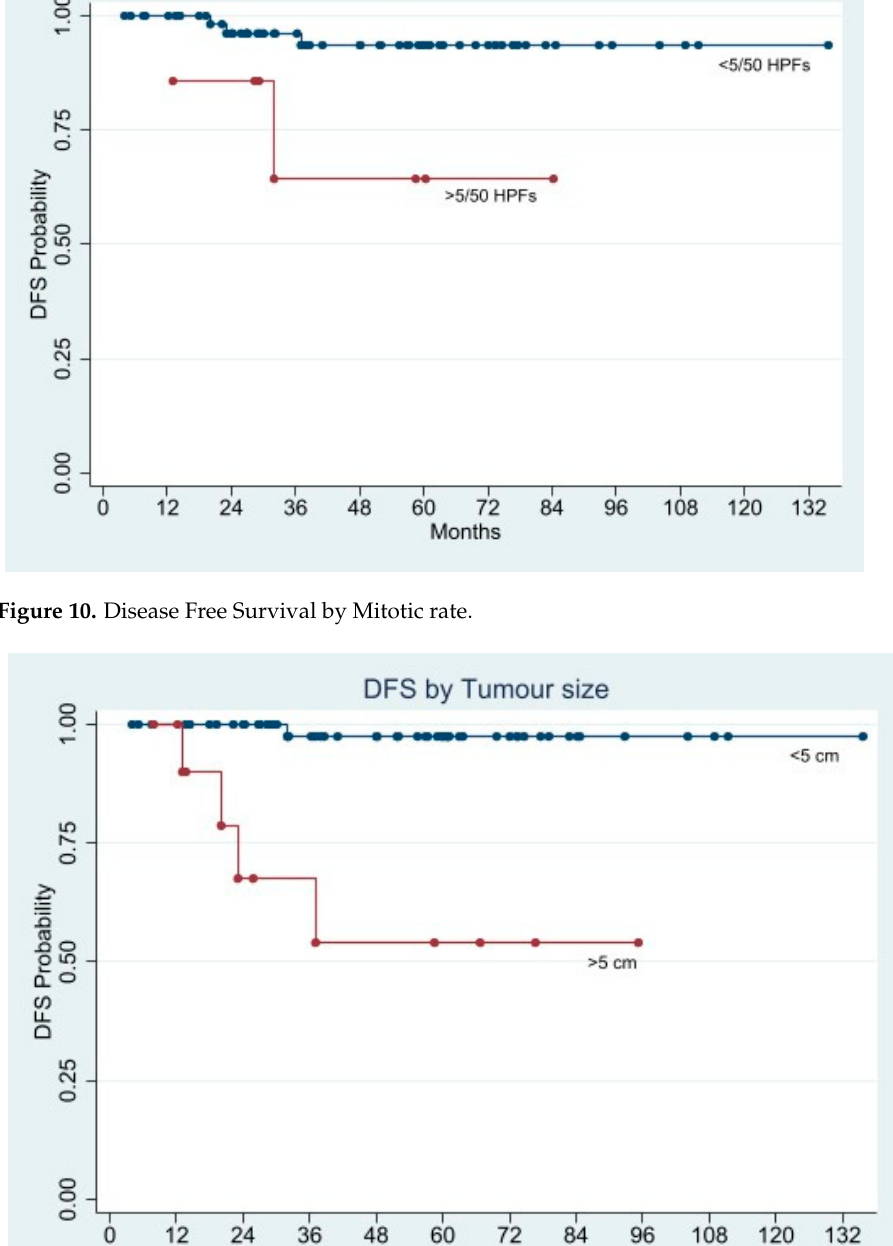
Figure 9. Disease Free Survival by Fletcher’s Risk class.